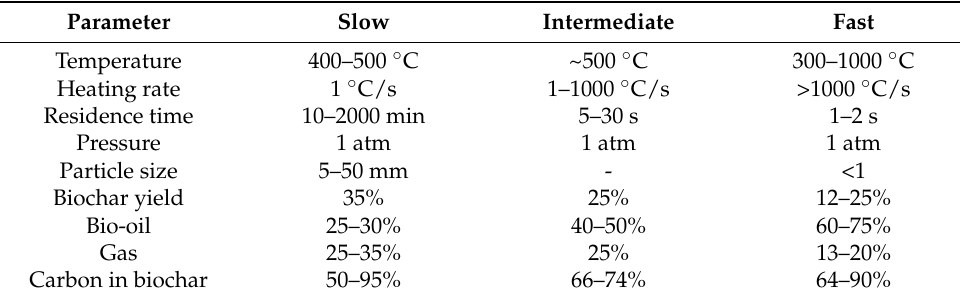
Table 4. Type of pyrolysis and corresponding product composition